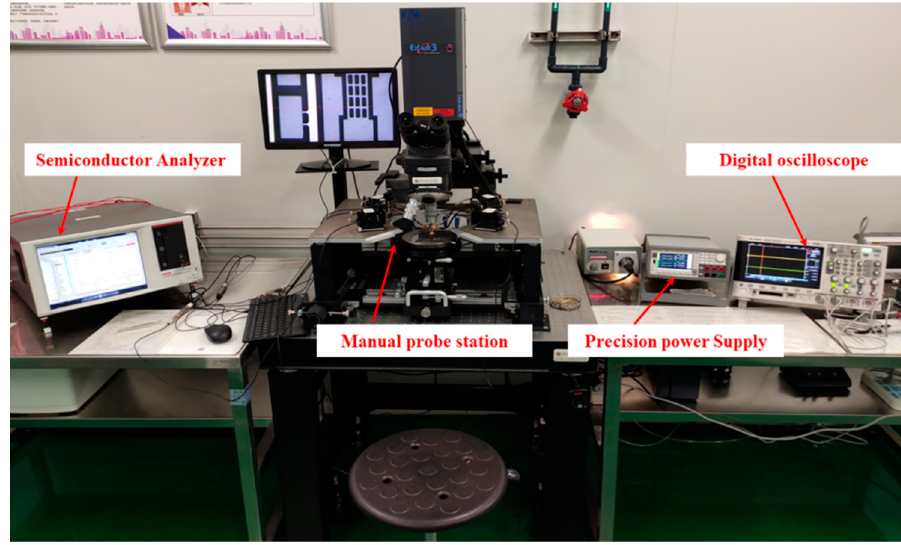
Figure 7. Experiment platform for electrical performance.